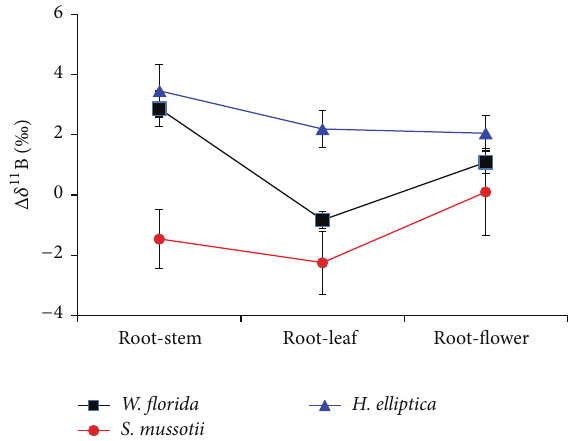
Figure 4: B isotope fractionation in tissues (stem, leaf, and flower) versus